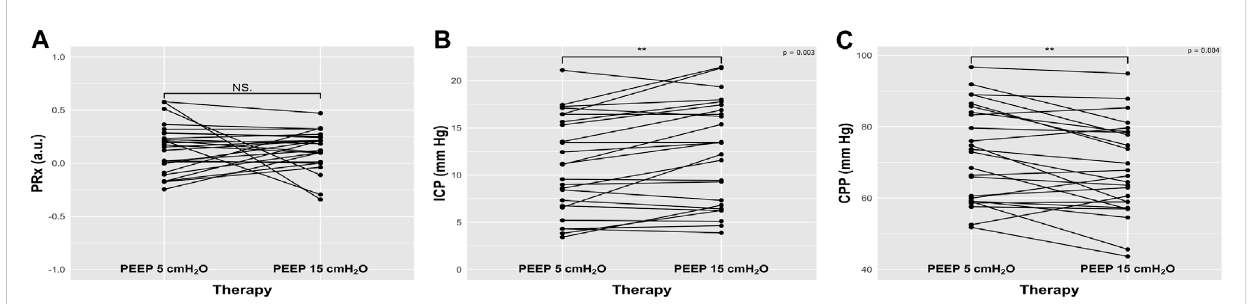
FIGURE 1 Plots representing the effect of increased positive end-expiratorypressure (PEEP) on cerebral autoregulation measured with pressure reactivity test (PRx), intracranial pressure (ICP), and cerebral perfusion pressure (CPP) from baseline. NS: not statistically signi fi cant; **: p <